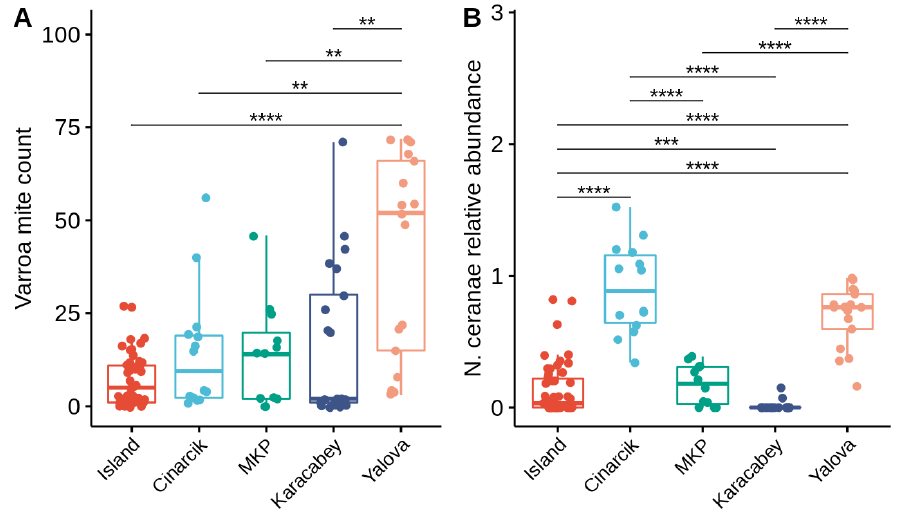
Figure 2. Median and inter-quartile range differences in Varroa mite count ( A ) and N. ceranae relative abundance ( B ) of colonies sampled from the five different apiary locations. Each color corresponds with a different sampling location. The sample size (n) is indicated below each box plot. Pairwise comparisons were done using Dun’s test and only significant differences were shown. **** p ≤ 0.0001, *** p ≤ 0.001, ** p ≤ 0.01.